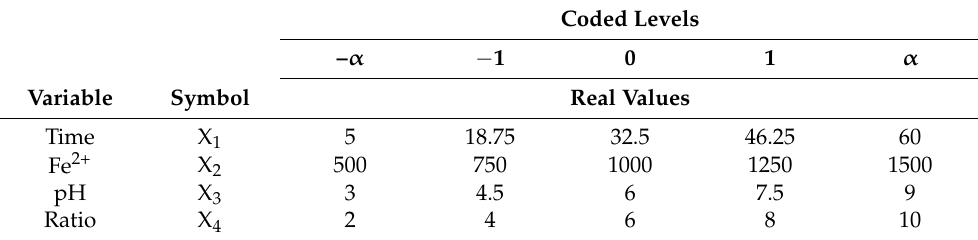
Table 4. Experimental range and levels used for the independent